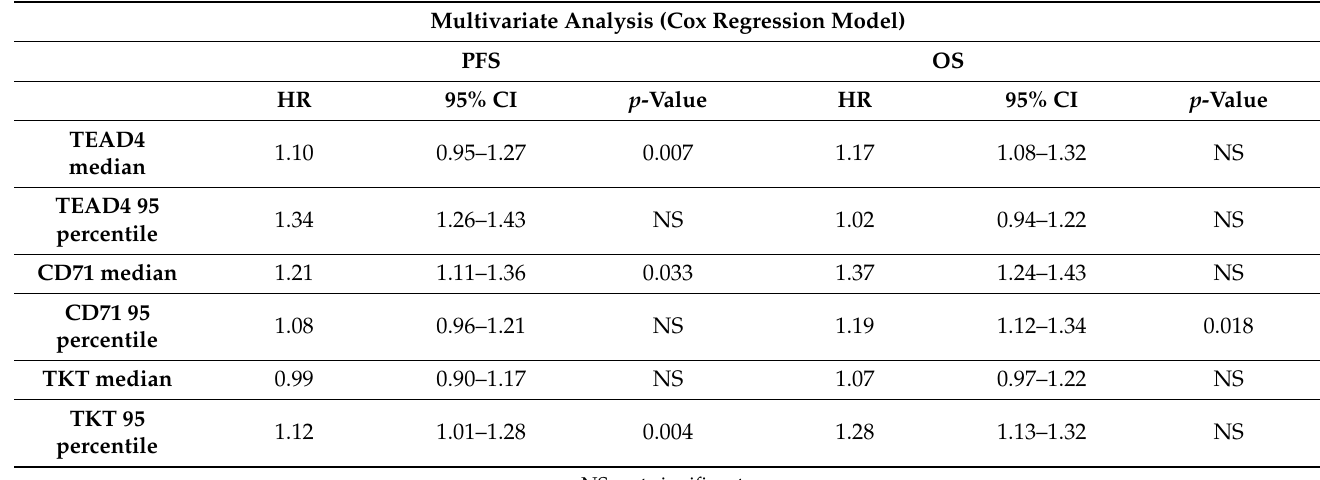
Table 8. Univariant and multi variant analyses (Cox regression model).